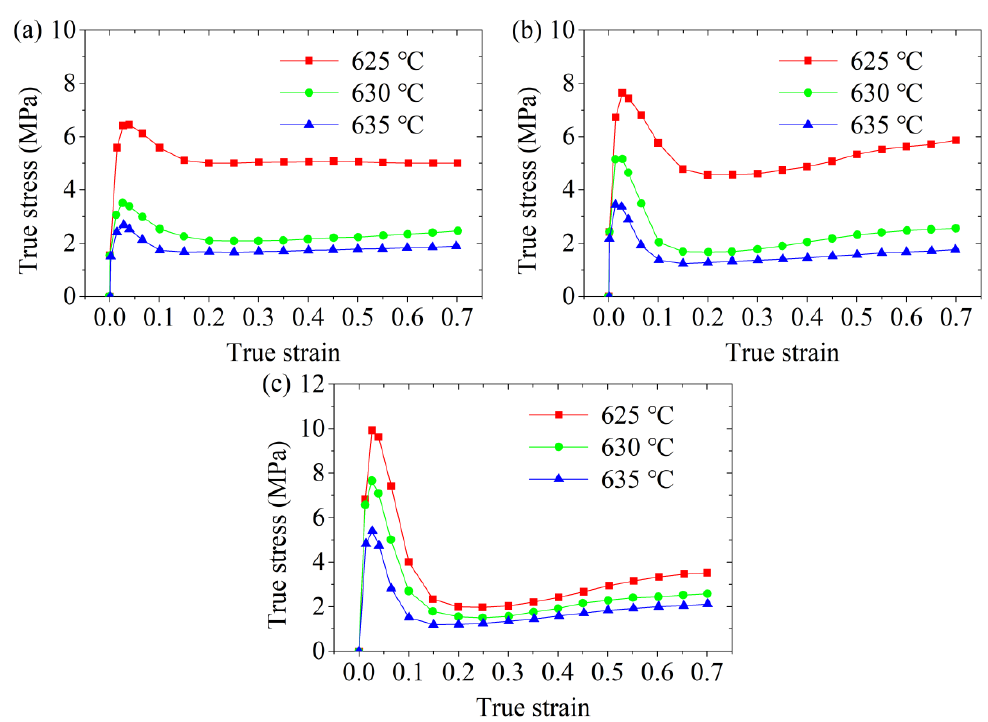
Figure 3. Ture stress-true strain curves of the cold radial forged 6063 aluminium alloy processed by the semi-solid isothermal compression at different temperatures with strain rates of ( a ) 0.01 s −1 , ( b ) 0.1 s −1 , and ( c ) 1 s −1 .